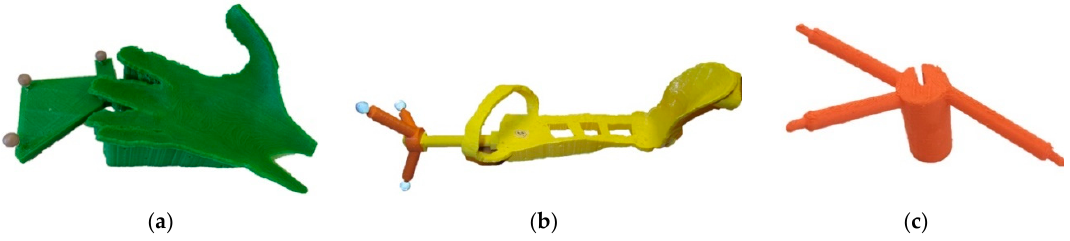
Figure 2. Three-dimensionally (3D) printed models with a rigid body (RB) attached to them: ( a ) patient-specific mold for case 1; ( b ) patient-specific mold for case 2; ( c ) electric scalpel customizable cap.